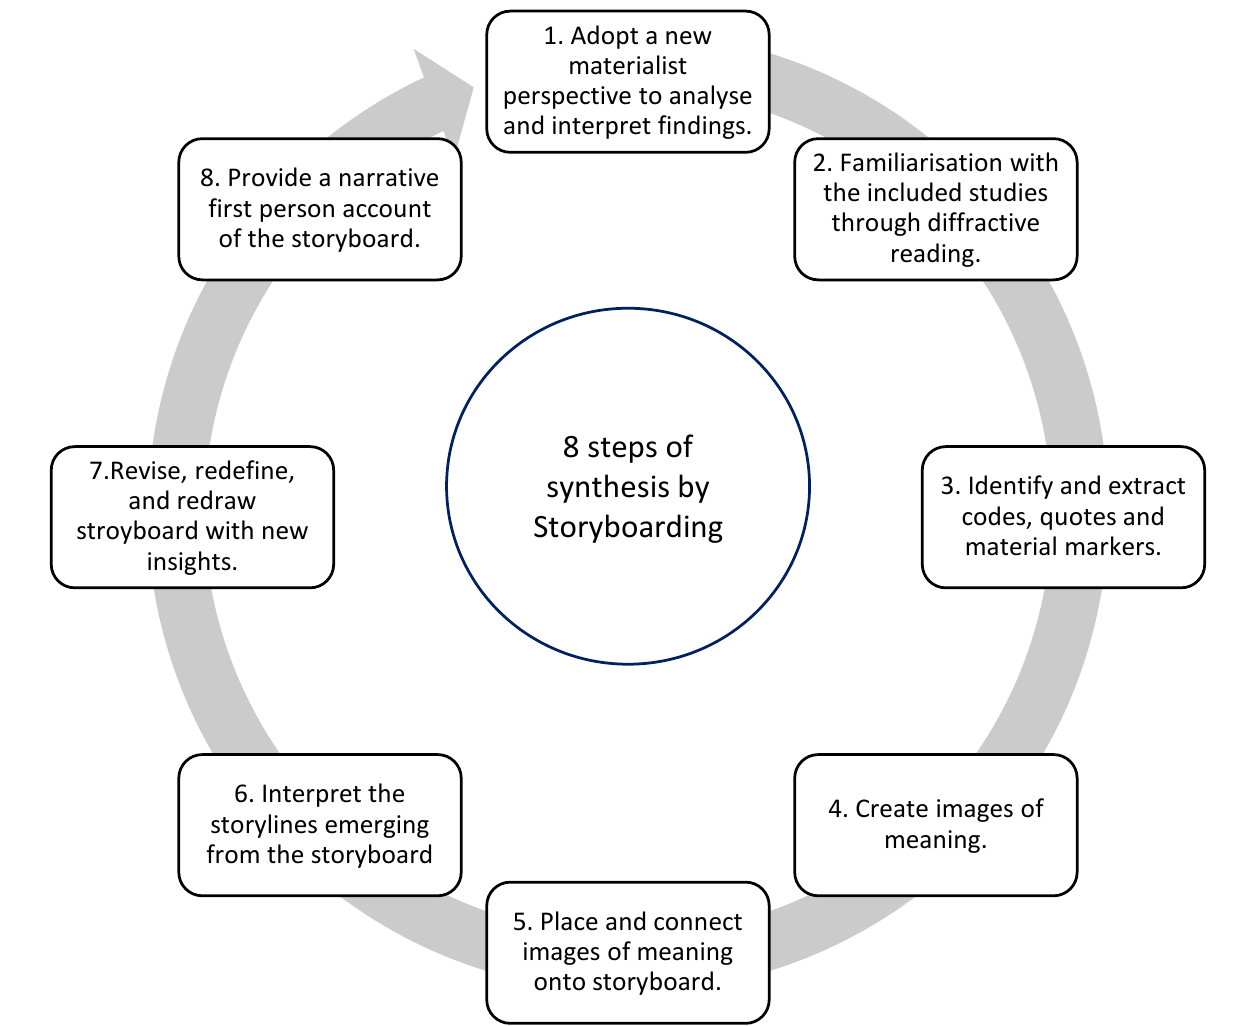
Figure 2: Synthesising multi-modalities using storyboarding